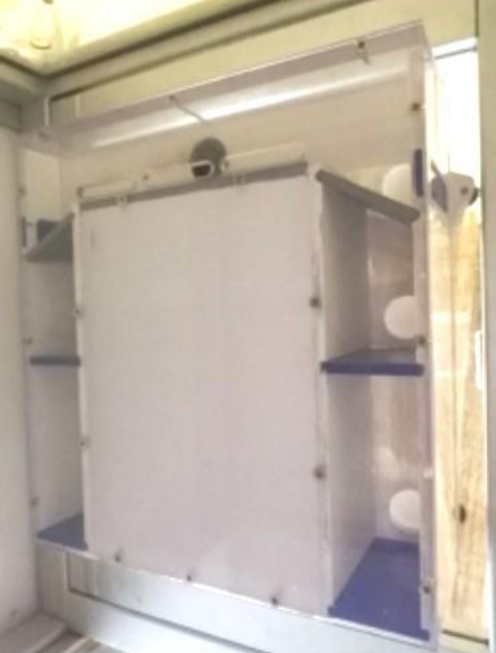
The Two-Trap-Box the Trap-Box from the Monkeys’ Perspective, With All Traps in Place, Installed in the Window of